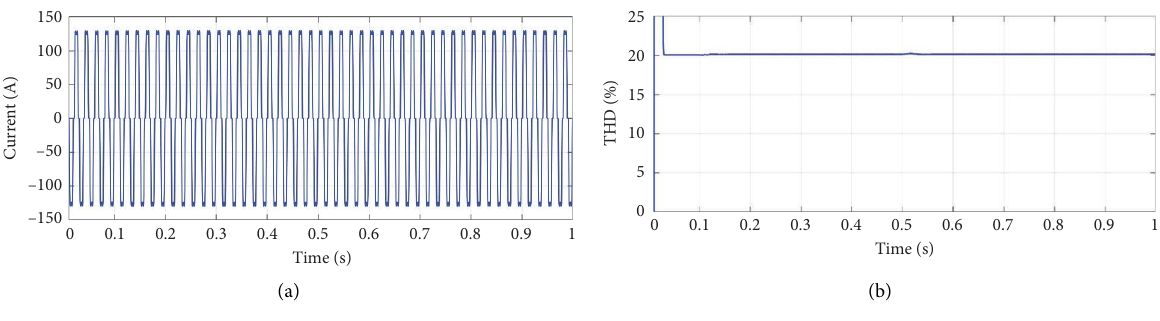
Figure 15: Load current (a) and its THD (b).